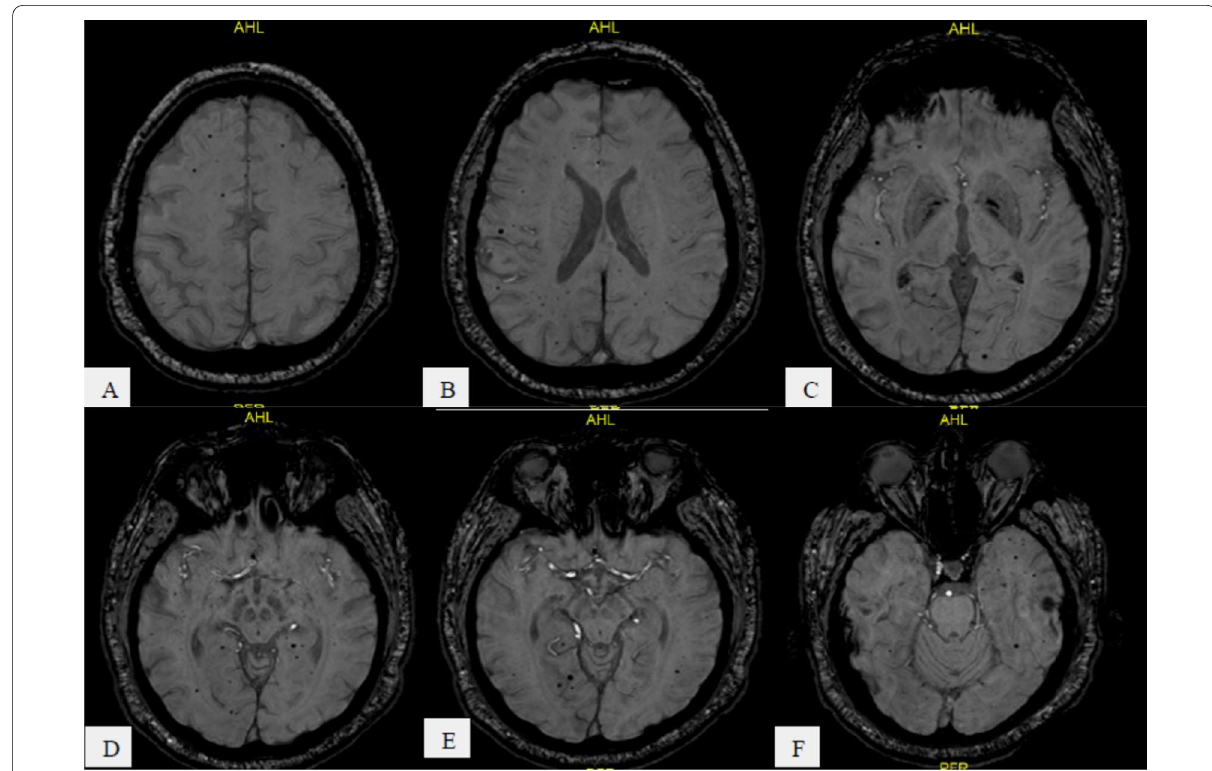
Fig. 7 42-year-old COVID-19 male patient with impaired level of consciousness, A – F serial axial MRI SWI sequences show innumerable variable size multiple scattered minute discrete foci of abnormal blooming signal that seen in both cerebral deep white matter on suggesting of COVID-19-related microhemorrhage